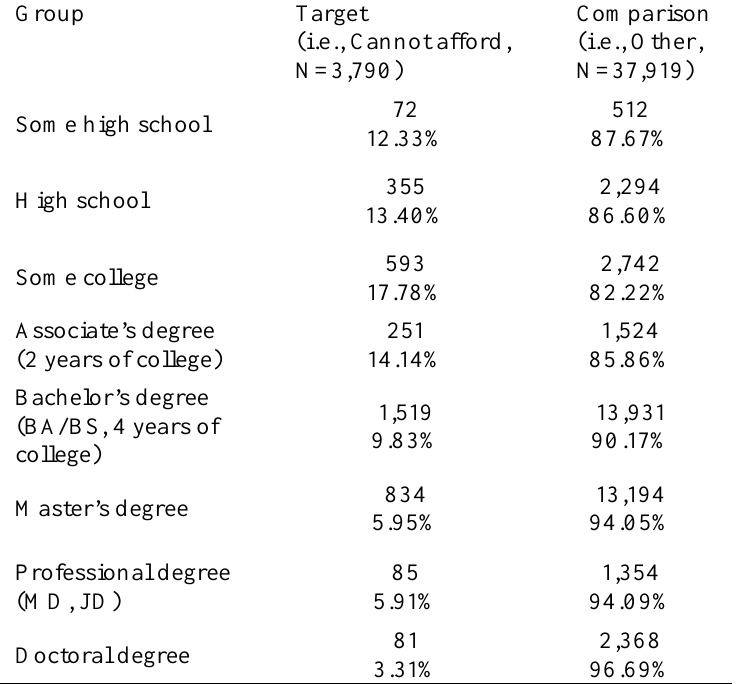
Table 6 Degree Achievement for Learners in the Target and Comparison Groups